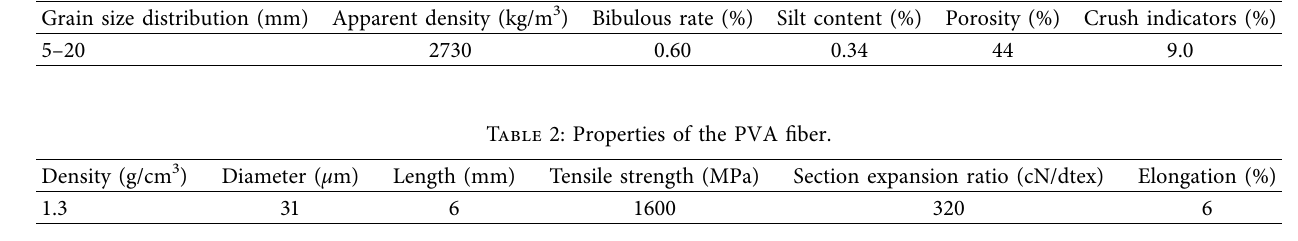
Table 1: Property index of coarse aggregate.